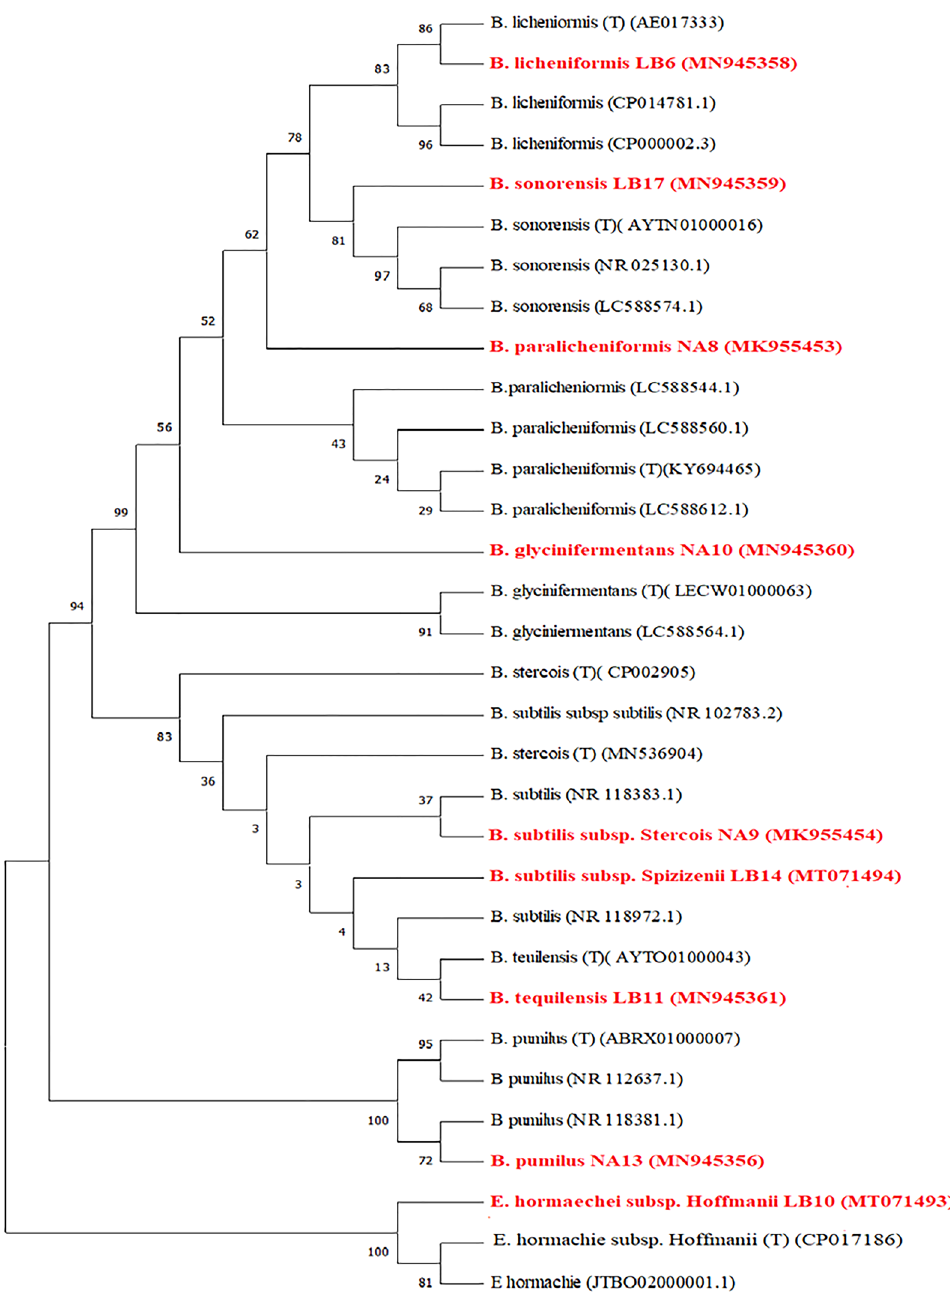
Figure 3. Phylogenetic tree of selected nine bacterial strains inferred using the Neighbor-Joining method. The optimal tree with the sum of branch lengths = 0.35042803 is shown. The percentage of replicate trees in which the associated taxa clustered together in the bootstrap test (1000 replicates) are shown next to the branches. The evolutionary distances were computed using the Maximum Composite Likelihood method and are in the units of the number of base substitutions per site. This analysis involved 32 nucleotide sequences. All ambiguous positions were removed for each sequence pair (pairwise deletion option). There were a total of 1469 positions in the final dataset. Evolutionary analyses were conducted in MEGA X The red colored names are the strains isolated from the rhizosphere of C. quinoa in this